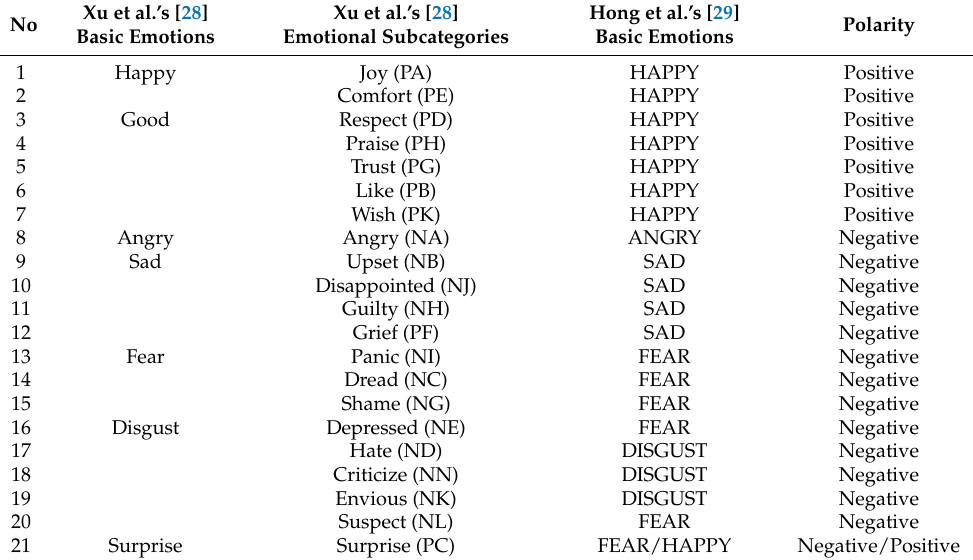
Table 2. Emotional framework and